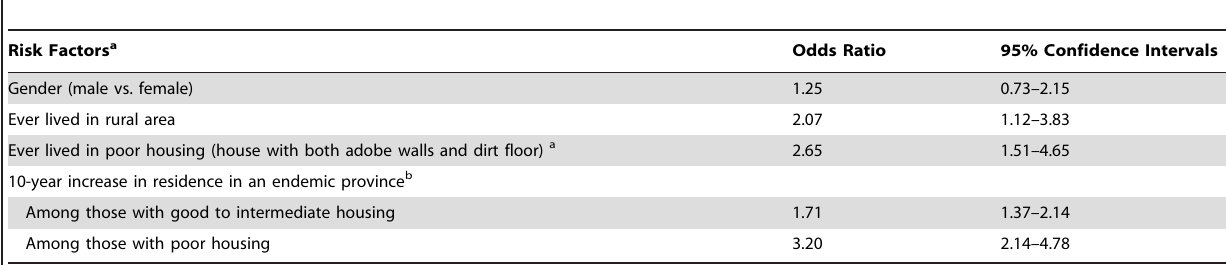
Table 3. Multivariable logistic regression model of factors associated with risk of Trypanosoma cruzi infection.